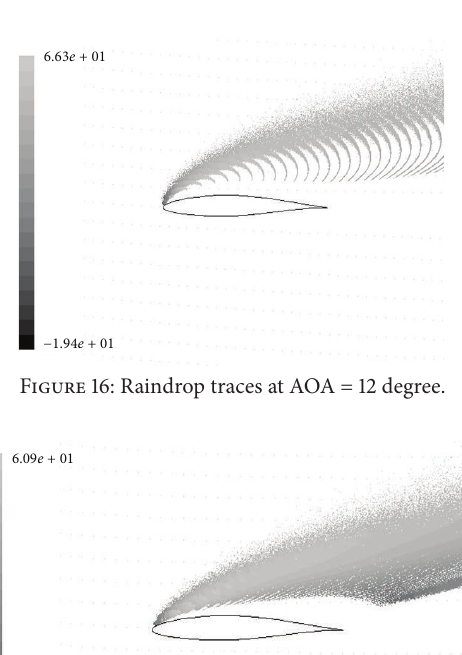
Figure 15: Raindrop traces at AOA = 8 degree.